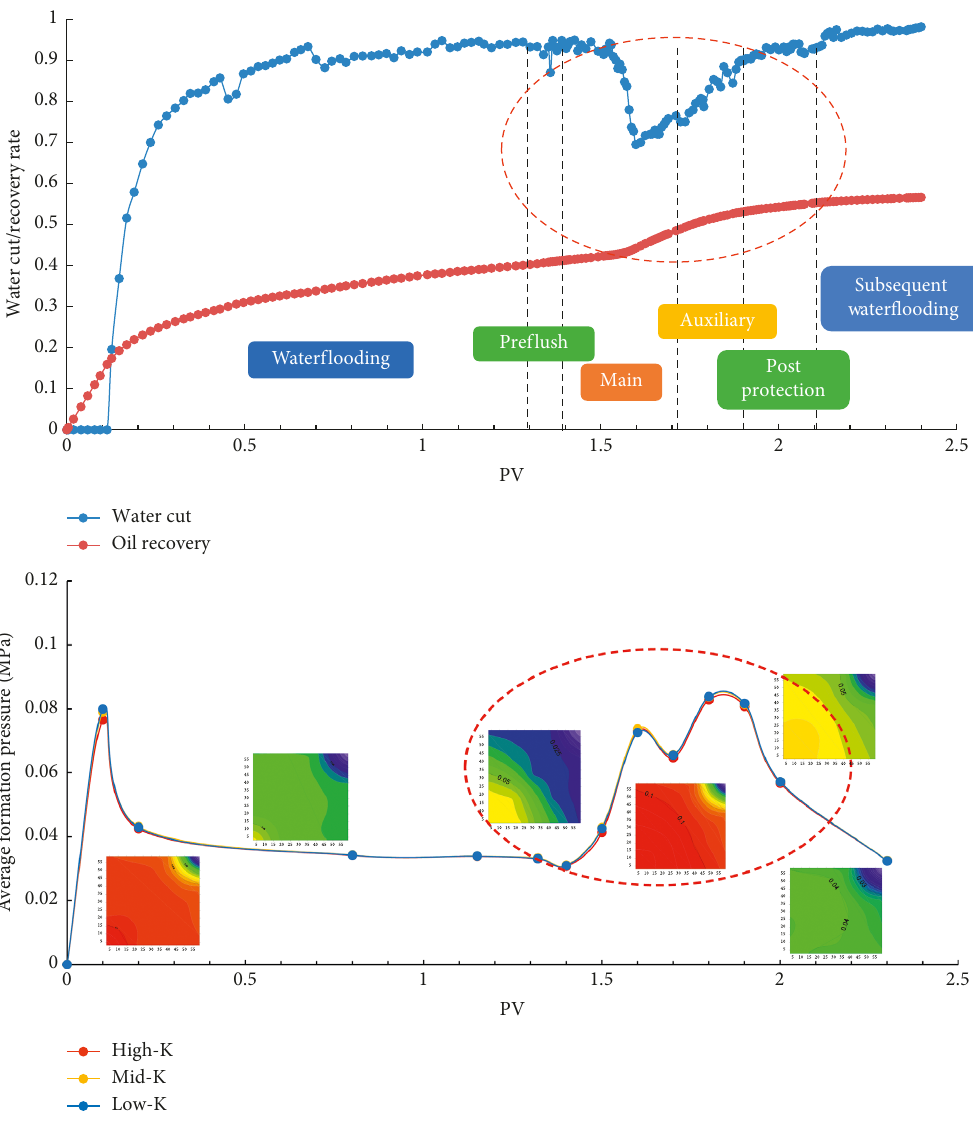
Figure 17: Production dynamics and pressure